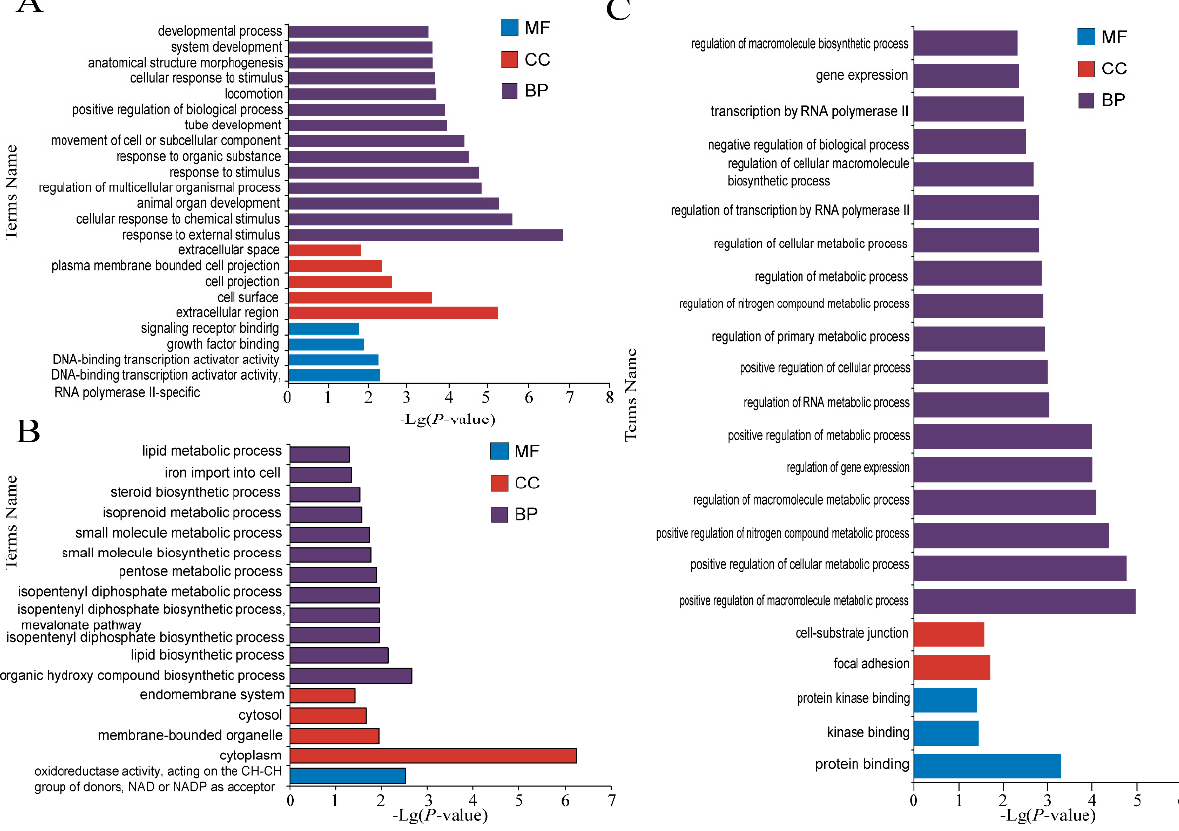
Figure 9. The functional enrichment analysis of specific genes expressed in the ovary of Small Tail Han Sheep. ( A ) Enriched GO terms of luteal phase, ( B ) Enriched GO terms of proestrus, ( C ) Enriched GO terms of estrus. Different bar chart colors represent different items. Purple represents BP, red represents CC, and blue indicated MF.